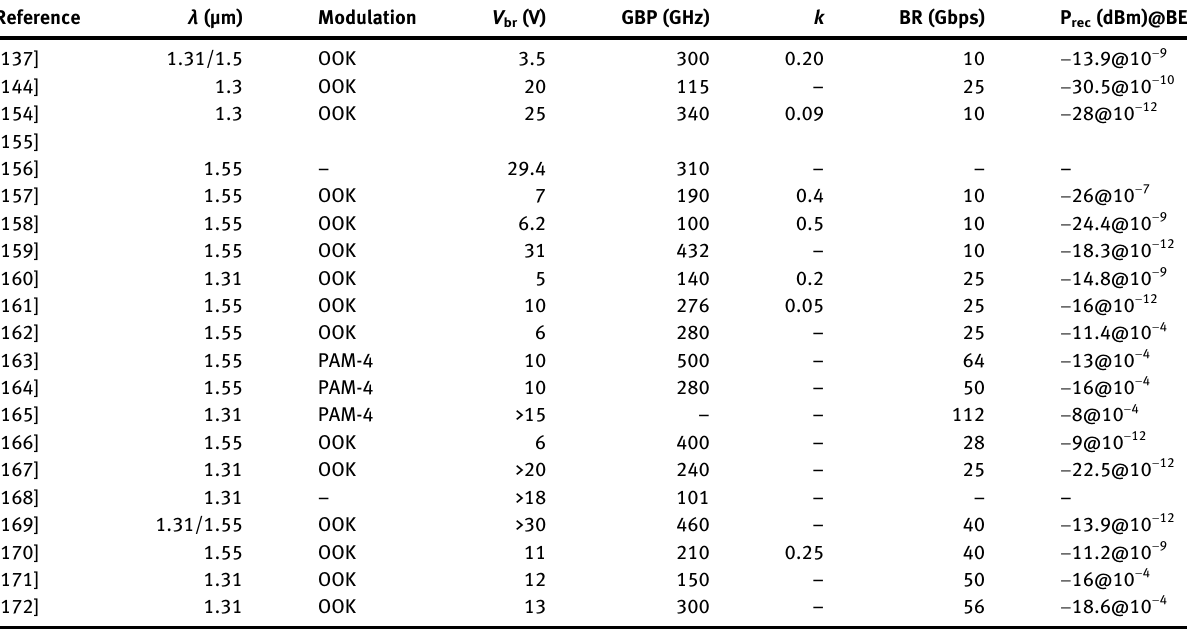
Table  : Properties of state-of-the-art Si – Ge avalanche photo-receivers operated at conventional optical communications wavebands.